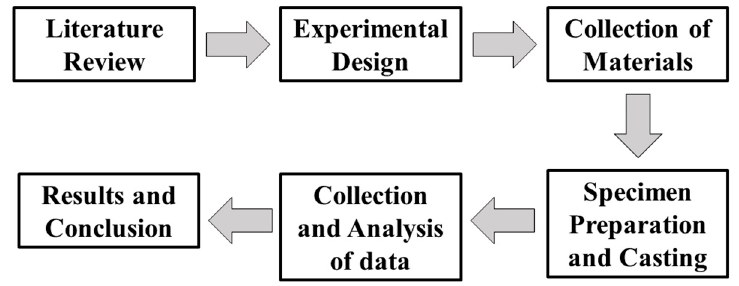
Figure 1. Schematic flowchart.